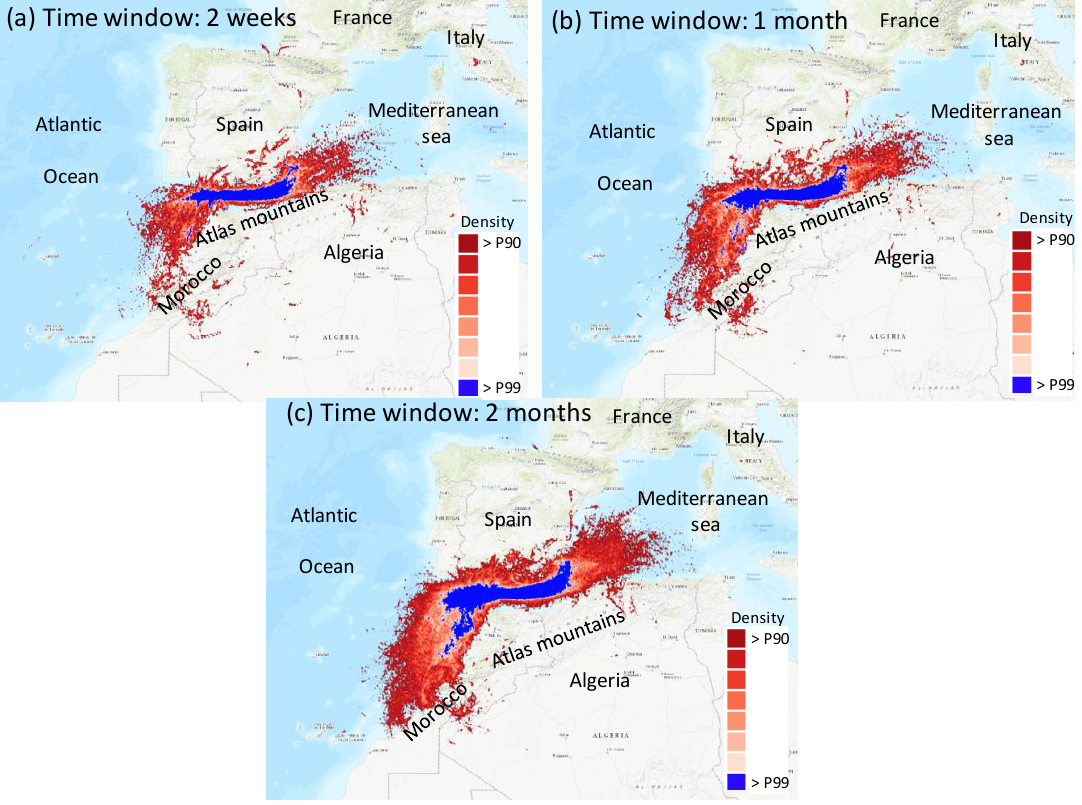
Figure 5. Density plots for 120-h trajectories starting at Algeciras and with a height below 100 m above ground level for ( a ) 2 weeks, ( b ) 1 month and ( c ) 2 months’ time window (reference date of 30 May) for the period 2007–2016 (Table 1). The density maps express the density of end-point positions estimated above 90%; quartic kernel function bandwidth 9 km.